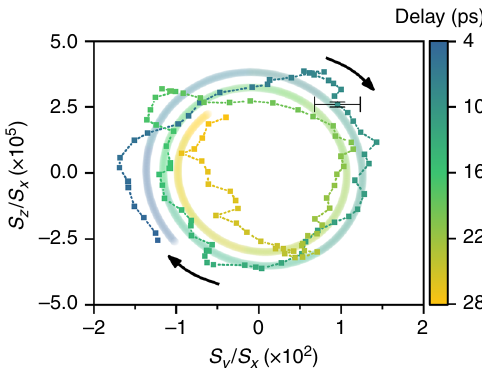
Fig. 4 Magnonic Z -mode precession. Time dependent amplitude of the spin motion in the yz plane obtained by combining fl oating time averages of SHG and Faraday-rotation measurements. The solid line is a fi t of a damped elliptical spin precession. For clarity, only two precession periods are